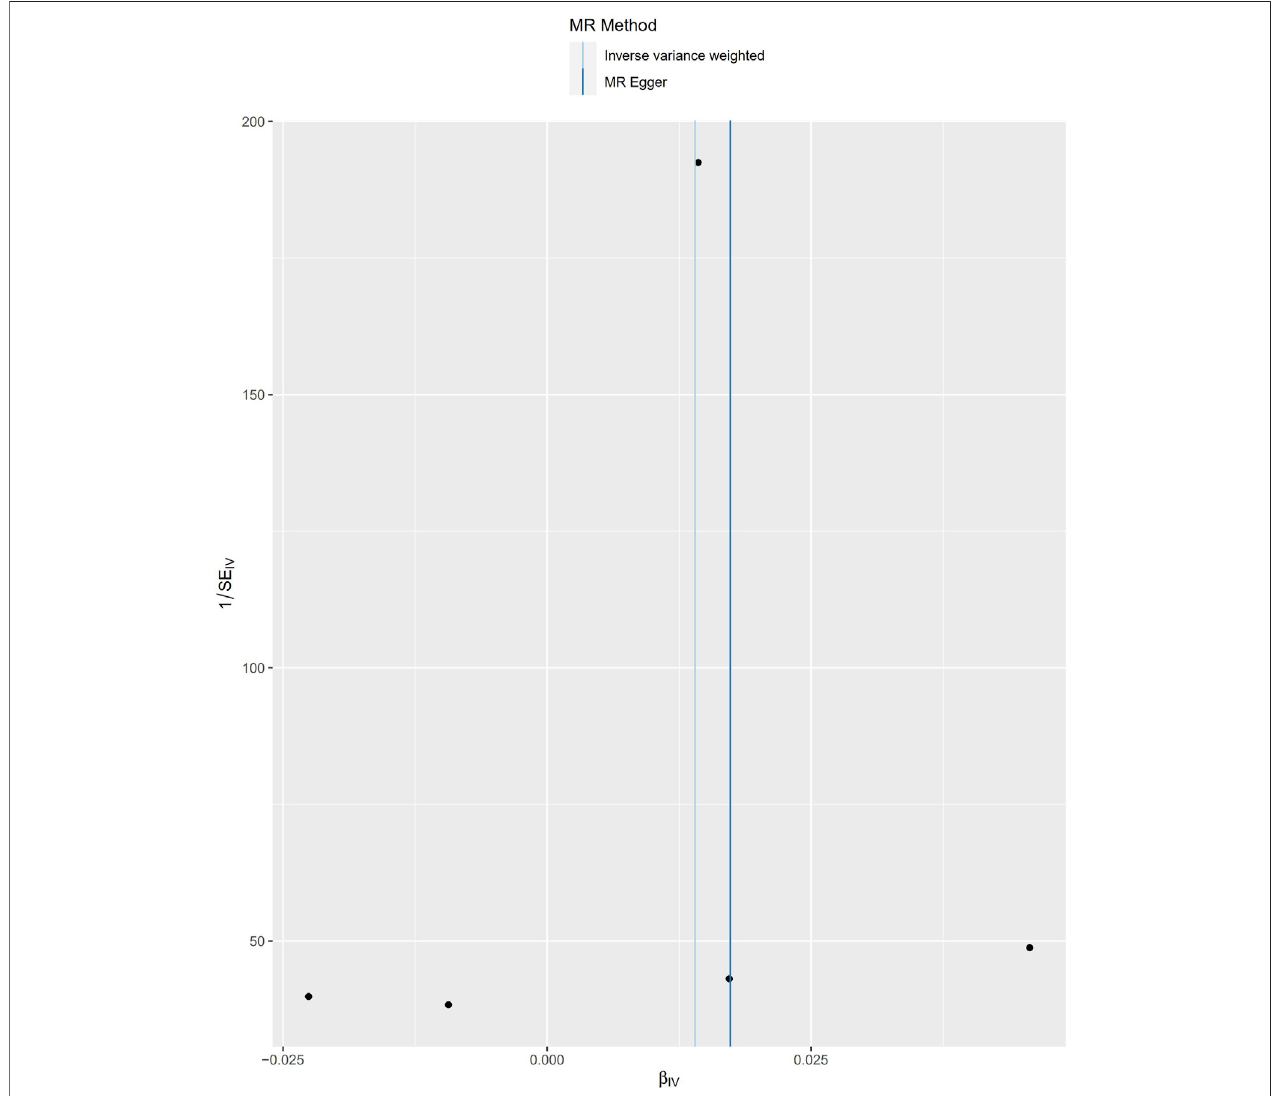
FIGURE 5 | Funnel plots to visualize overall heterogeneity of MR estimates for the effect of Cystatin C on total osteoporosis. IVW indicates inverse-variance weighted; and MR, Mendelian randomization.